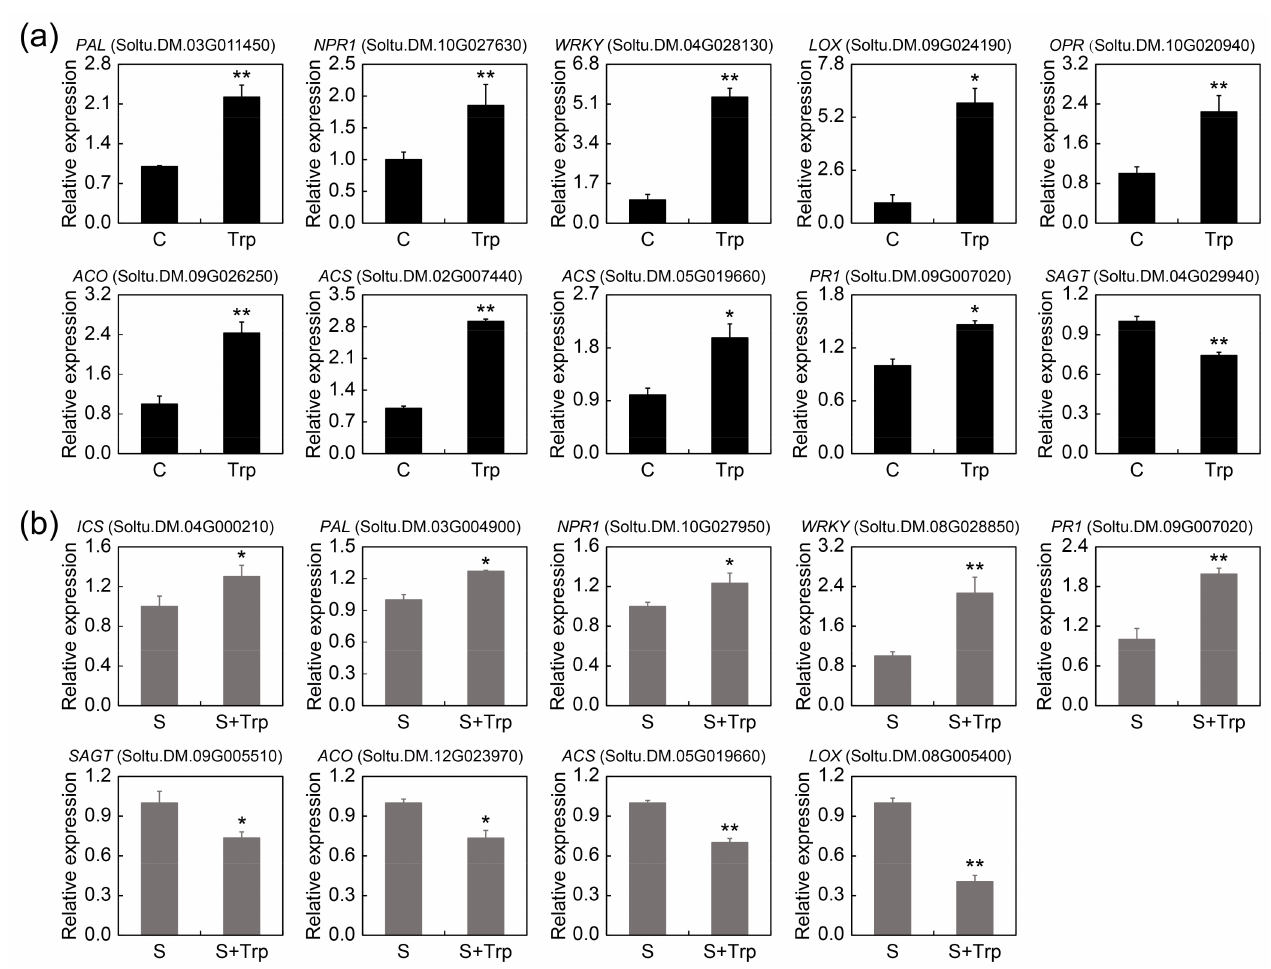
Figure 6. The relative expression of some candidate genes belonging to the C-vs-Trp group ( a ) and S-vs-S+Trp group ( b ) was detected by qRT–PCR. The asterisks denote statistically significant differences, as determined by Student’s t -test, * p < 0.05, ** p < 0.01. Three biological repetitions were